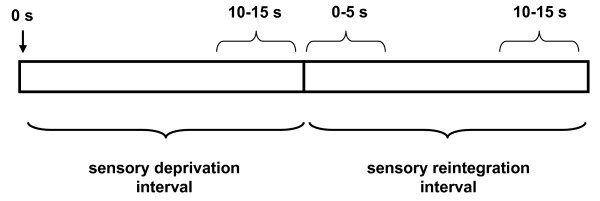
Temporal sequencing across sensory deprivation and sensory reintegration interval. A trial is made of a series of two 15 s intervals. The first interval, sensory deprivation, is performed under sensory deprivation (i.e. perturbed ankle proprioception and/or no vision). For the second interval (sensory reintegration interval), ankle proprioception and/or vision returned to normal. For the sensory deprivation interval, only the last 5 s epoch is used for data analysis. From the 15 s of the sensory reintegration interval, two epochs are selected. The first epoch represents the first 5 s whereas the second epoch concerns the last 5 s.